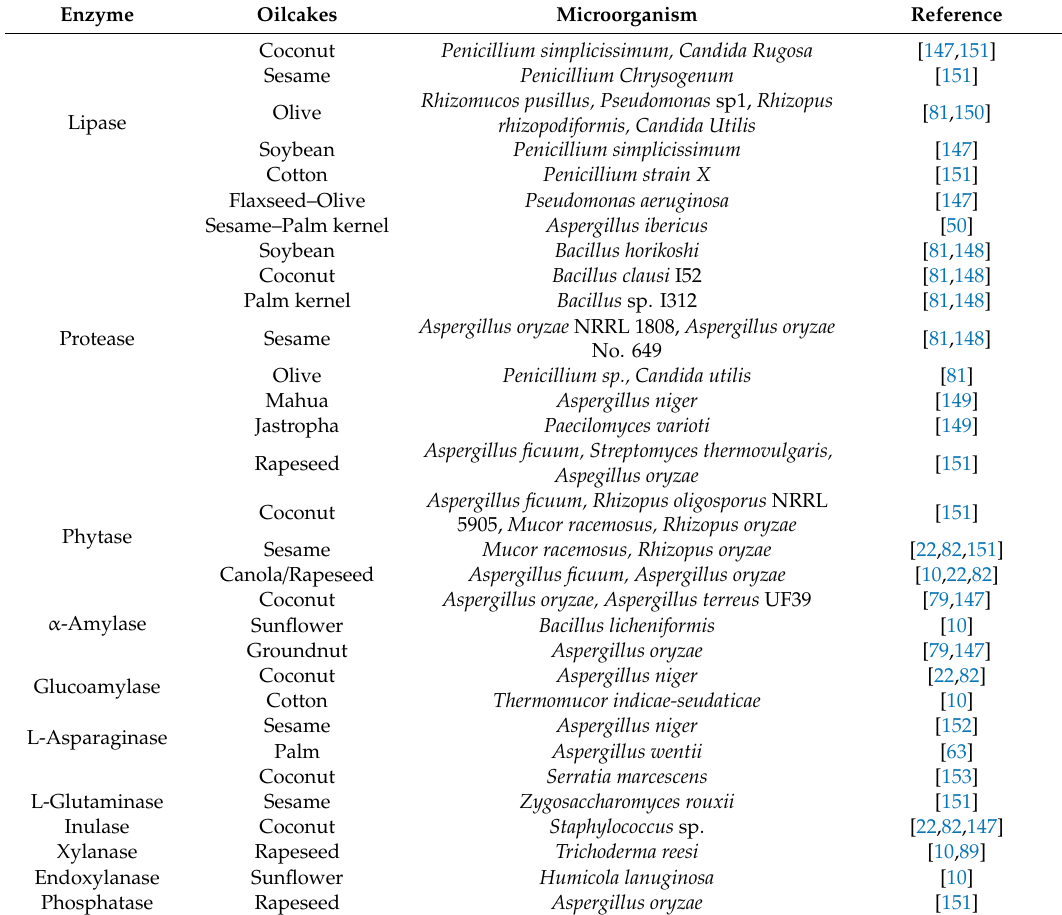
Table 4. Production of enzymes through solid state fermentation using as substrates oil